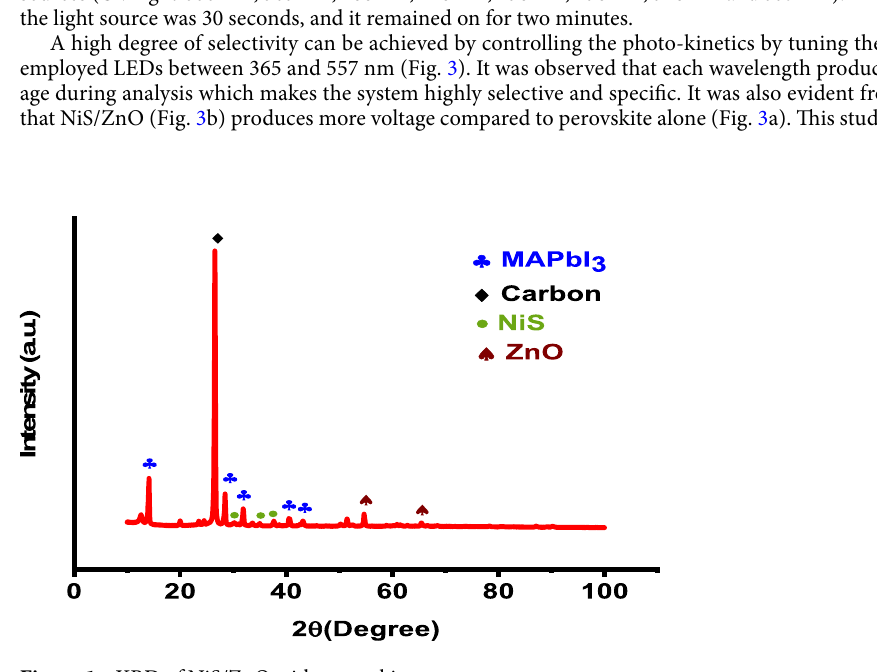
Figure 1. XRD of NiS/ZnO with